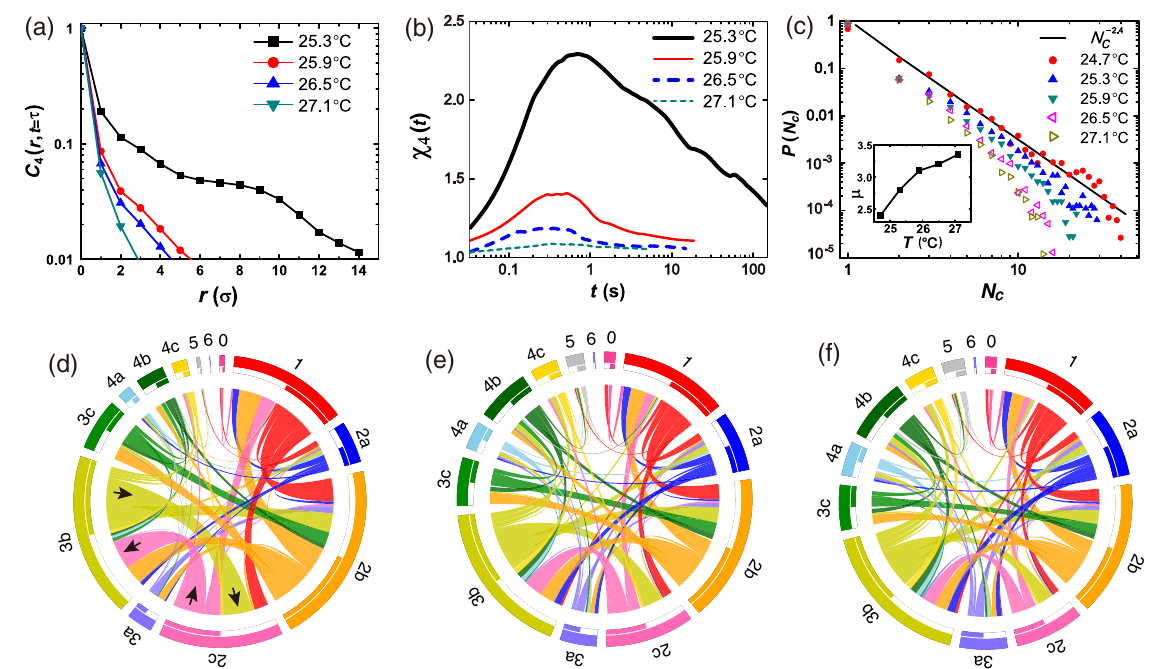
FIG. 4. Glassy dynamics in the repulsive buckled crystal. The simulation counterpart is Fig. S6 of SM [14]. (a) Four-point spin correlation function C 4 ð r; t ¼ τ Þ . (b) Dynamical four-point susceptibility χ 4 ð t Þ . (c) The probability distributions of the cluster size N of c ∝ N − μ μ is shown in the inset. (d) – (f) Statistics of the the 10% most flipped spins at different temperatures. The fitting line P ð N c , where c Þ transition events among 13 motifs shown by circular flow plots at (d) 24 . 7 °C, (e) 25 . 3 °C, and (f) 27 . 1 °C. The length of the outer thick arc is proportional to the total number of spin flips from or towards the labeled motif number. The flips from the motif are labeled by the color of the motif arc. Some inflows and outflows between motifs 2c and 3b are labeled with arrows as examples. The inner thin arc length is proportional to the number of flips from the motif, and is half the length of its corresponding outer thick arc. Hence, the incoming and outgoing flows are equal, as required by the detailed balance under